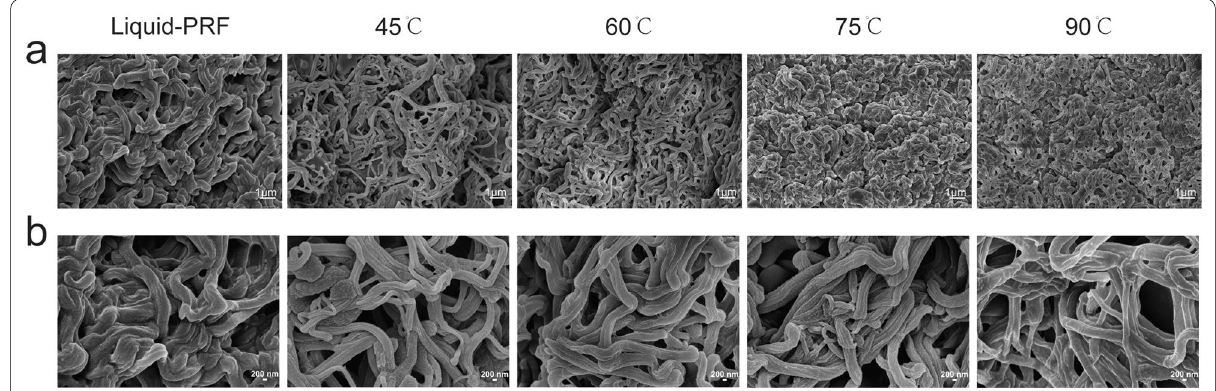
Fig. 4 SEM images of H-PRF